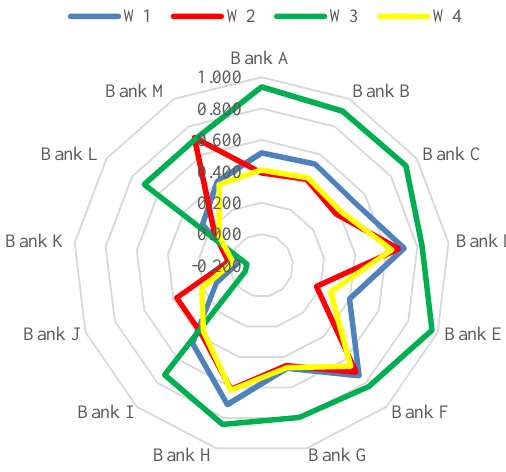
Figure 2. Resistance of commercial banks to potential COVID-19 pandemic impacts as determined by TOPSIS taking into account different weighting systems (Option 1)